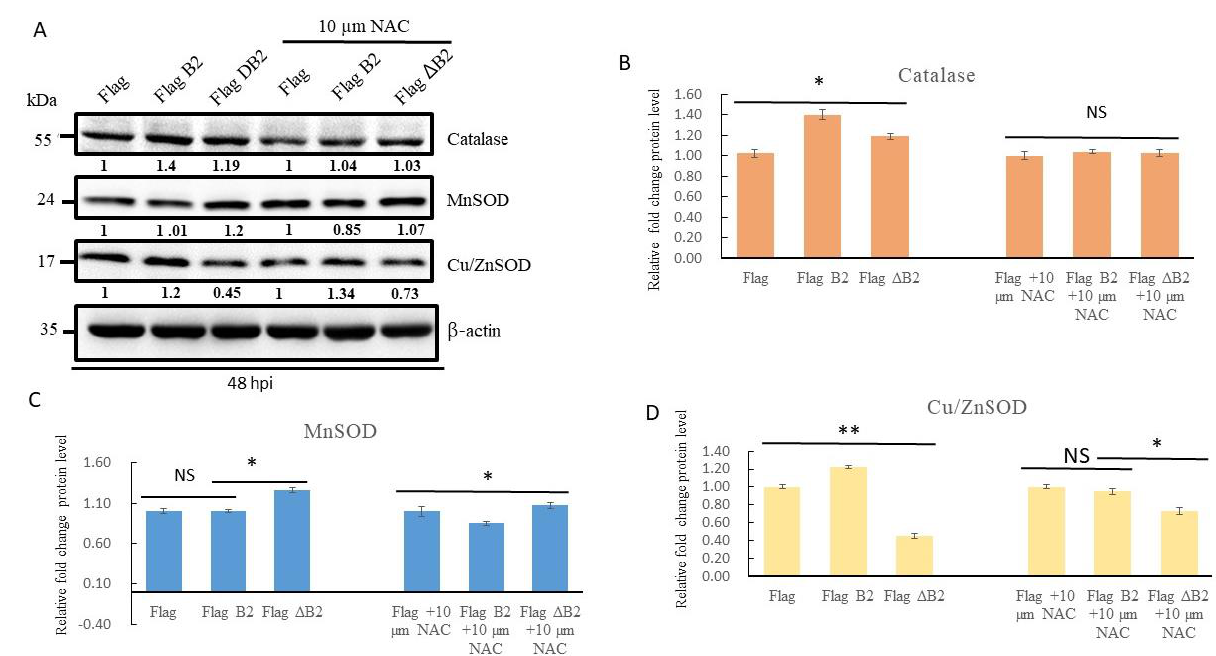
Figure 3. Identification of NAC-inhibited B2 protein-induced stress markers in A549 cells. ( A ) Sup- pression of B2 (2 mM)-mitochondria-targeting-induced catalase, MnSOD, and Cu/ZnSOD expression in A549 cells by Western blot analysis. The group treated with N-acetyl-L-cysteine (NAC, 2 mM) was used in the PEI (3.2 µ g) and the recombinant plasmid (3.2 µ g) group for 48 hpt. ( B – D ) Quantification of the results in A. The data are representative of three separate experiments, and the bars represent the SEMs. * p < 0.05 and ** p < 0.01, NS = not significant, as analyzed by one-way ANOVA with Tukey’s multiple